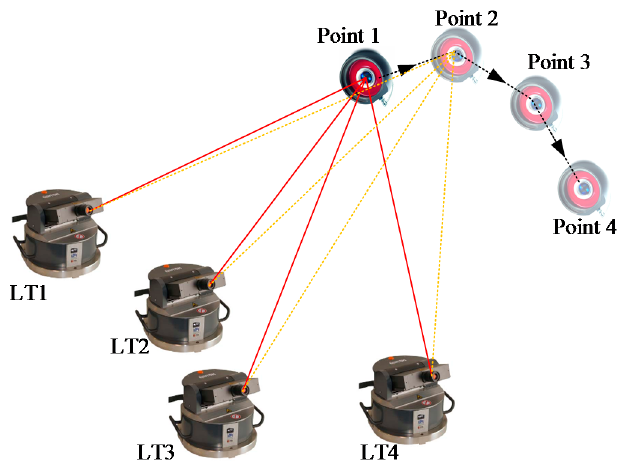
Figure 3. Multilateration requires more than four LaserTRACERs for target spatial position computing, where Point 1 to Point 4 represent the target points 1 to 4, LT1 to LT4 represent the position of the LaserTRACER No. 1 to No. 4.